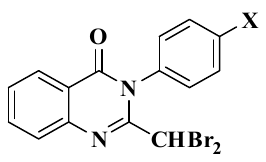
Figure 2. 2-dibromomethyl-3-p-substitutedphenyl-4( 3H )-quinazolinone derivatives ( 2a–d ) (X = F, Cl, Br, NO 2 ). Table 2. Properties of the synthesized 2-dibromomethyl-3-p-substitutedphenyl-4( 3H )-quinazolinone derivatives ( 2a–d ).